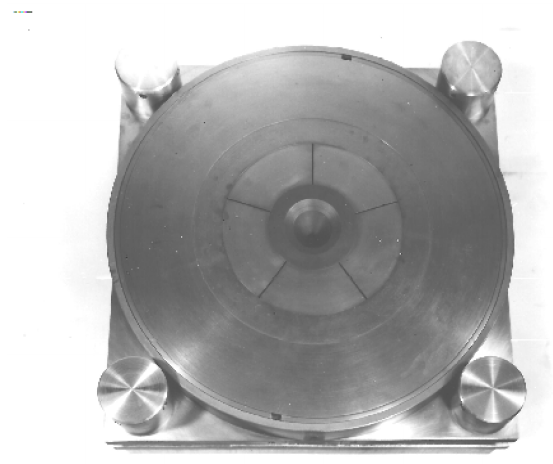
Figure 19. Split belt ring system.